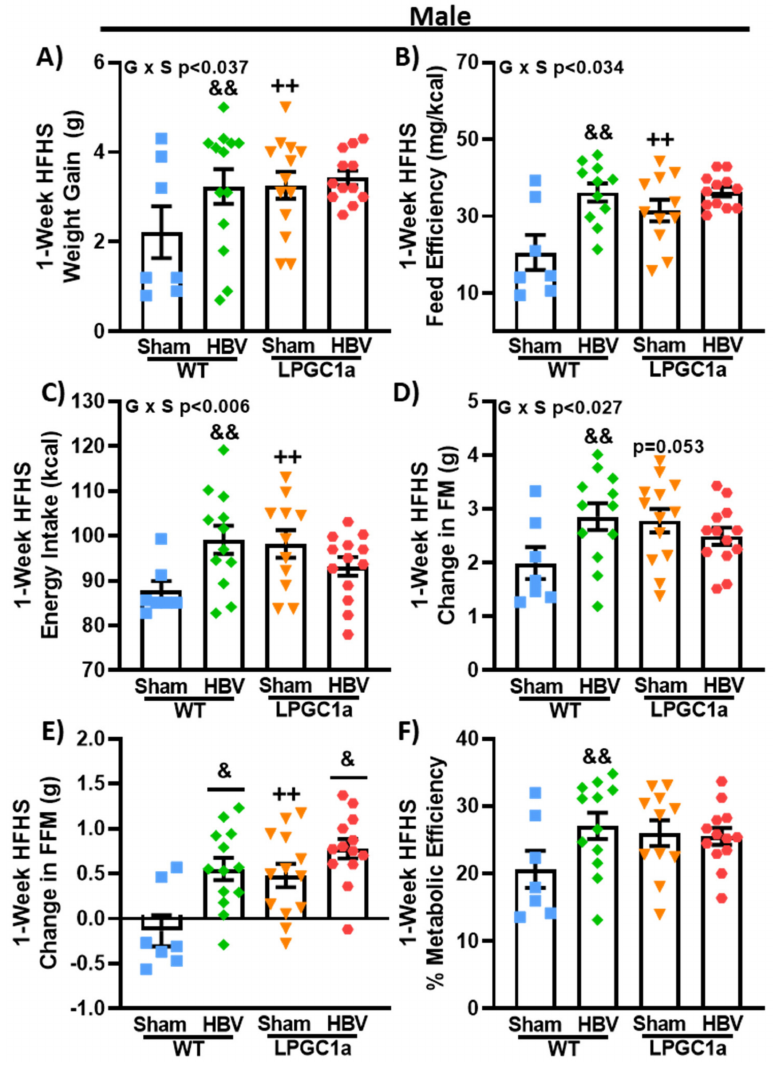
Figure 7. Disruption of liver vagal innervation by common hepatic branch vagotomy increases short-term diet-induced weight gain in WT, but not LPGC1a, male mice. Male WT and LPGC1a mice underwent sham or HBV surgery, and were administered a one-week HFHS diet following recovery. ( A ) One-week HFHS-induced weight gain. ( B ) Feed efficiency was determined as the body weight gained divided by the energy intake during the one-week HFHS diet. ( C ) Energy intake was calculated as the energy density of the HFHS diet multiplied by the one-week food intake. A quantitative MRI was utilized to determine fat- and fat-free mass at the initiation and end of the one-week HFHS diet, and the change in fat mass ( D ) and the fat-free mass ( E ) are presented. Based on the change in fat- and fat-free mass the ( F ) metabolic efficiency of weight gain was calculated as the sum of the energy content of fat and fat-free mass multiplied by the respective changes over the one-week HFHS diet, divided by the one-week energy intake. Individual data points and the group means ± SEM are displayed ( n = 7–12). Genotype x Surgery p < 0.05 interaction of genotype and surgery, & p < 0.05 main effect of HBV, && p < 0.05 sham vs. HBV within genotype, ++ p < 0.05 WT vs. LPGC1a within